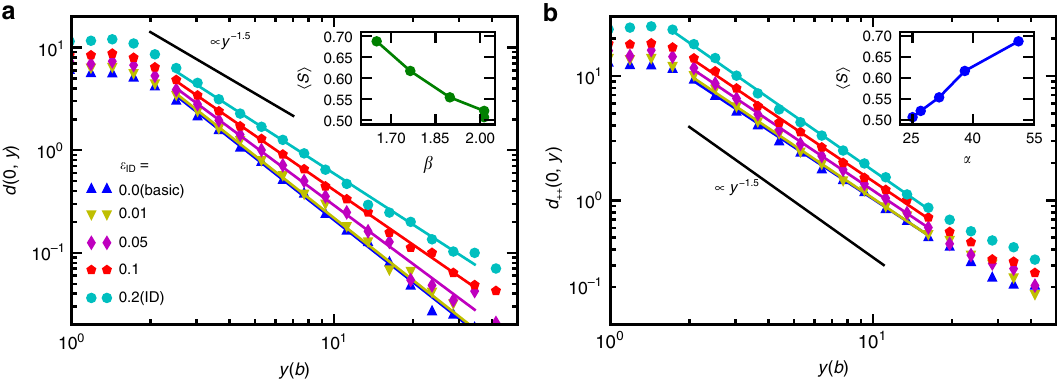
Fig. 3 Dislocation correlations and predictability. a Average pair correlation functions d (0, y ) of initial dislocation con fi gurations along the y -direction for N = 400 obtained with varying amount of pre-strain (See Fig. 1d,e for the full d ( x , y ) in basic and ID systems, respectively). With larger pre-strain the correlations, i.e., dislocation walls, become larger. The colored solid lines show fi ts of the form of d (0, y ) = α y − β and the black solid line illustrates ∝ y − 1.5 for reference 25,26 . The inset shows that smaller β implies better predictability with large strains as the average score in the range ε ∈ [0.15, 0.2] (for full curves see Supplementary Fig. 3) decreases with growing β . b The correlation functions d ++ (0, y ) of positive dislocations with similar power-law fi ts. Now β is close to 1.5 so the pre-factor α versus the average score is plotted in the